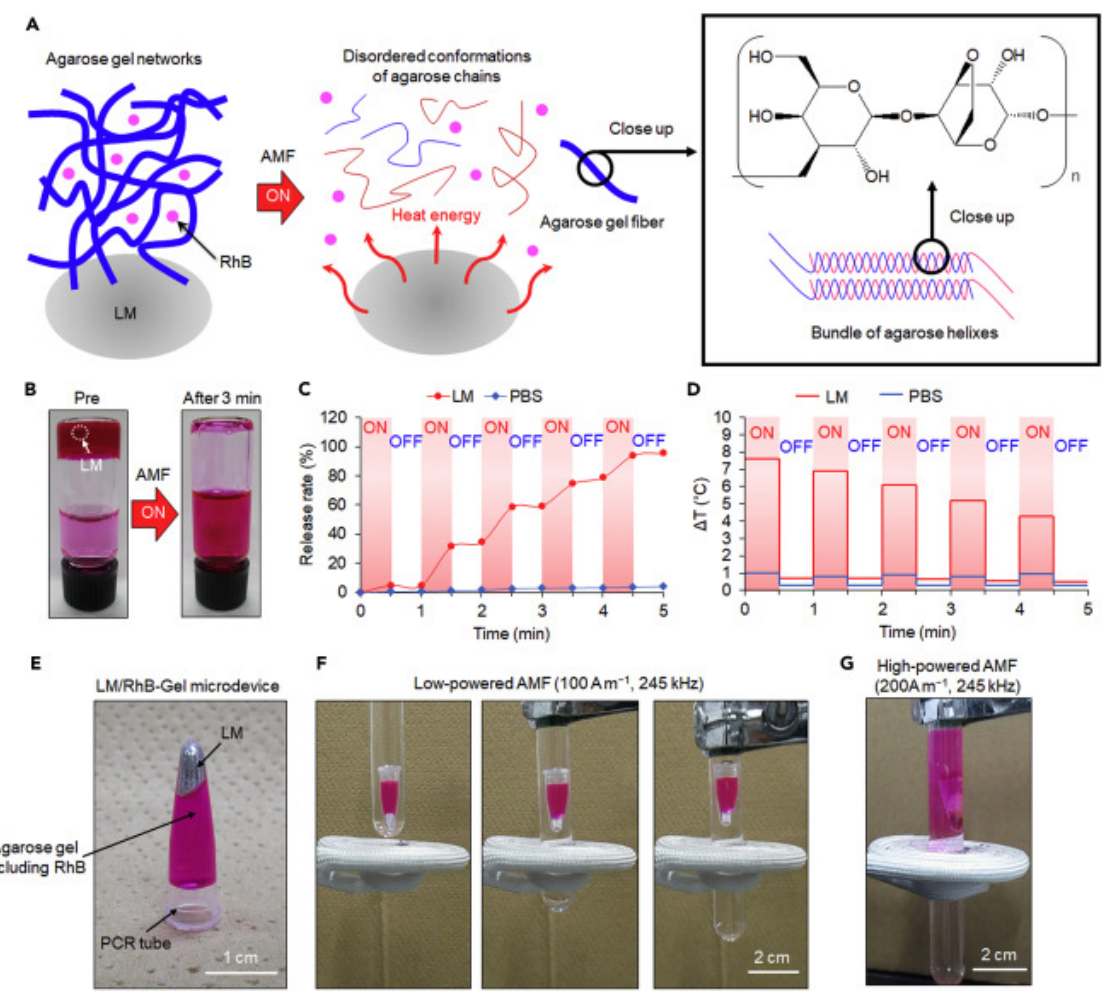
Figure 9. Alternating magnetic field (AMF)-controlled spatiotemporal drug release from a liquid metal (LM)–hydrogel microdevice. ( A ) Schematic illustration showing gel-sol transition of LM–agarose gel composite upon AMF induction. ( B ) A 1 mL hydrogel matrix (agarose, 2% w w − 1 ; rhodamine B (RhB), 0.5 mg mL − 1 ) containing LM (20 µ L) in addition to 2 mL water before and after AMF (200 A m − 1 , 245 kHz) exposure for 3 min. ( C , D ) AMF-modulated release profile ( C ) and temperature change ( D ) of LM- or phosphate-buffered (PBS)-containing hydrogel matrix over a period of time. The “ON” stage indicates exposure to the AMF (200 A m − 1 , 245 kHz), whereas the “OFF” stage indicates the absence of AMF. ( E ) Depiction showing the LM/RhB-Gel microdevice consisting of LM (20 µ L), agarose (2%, w w − 1 , 200 µ L), RhB (0.5 mg mL − 1 ), and a polymerase chain reaction (PCR) tube. ( F ) Sequential snapshots showing the LM/RhB-Gel microdevice electromagnetic levitation induced with low-powered AMF (100 A m − 1 , 245 kHz). ( G ) Photograph showing the LM/RhB-Gel microdevice electromagnetic levitation and RhB release behavior induced with high-powered AMF (200 A m − 1 , 245 kHz). Reproduced with permission from